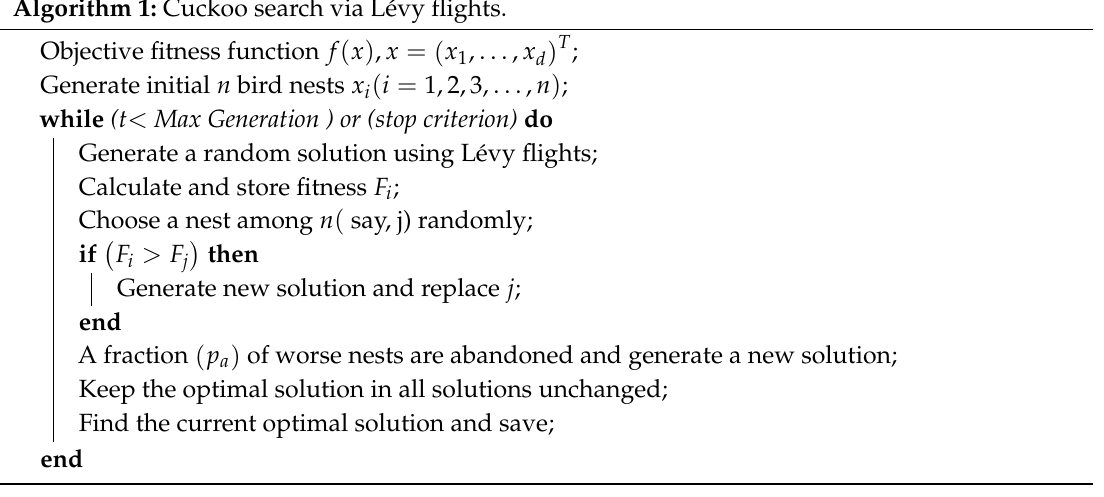
Algorithm 1: Cuckoo search via Lévy